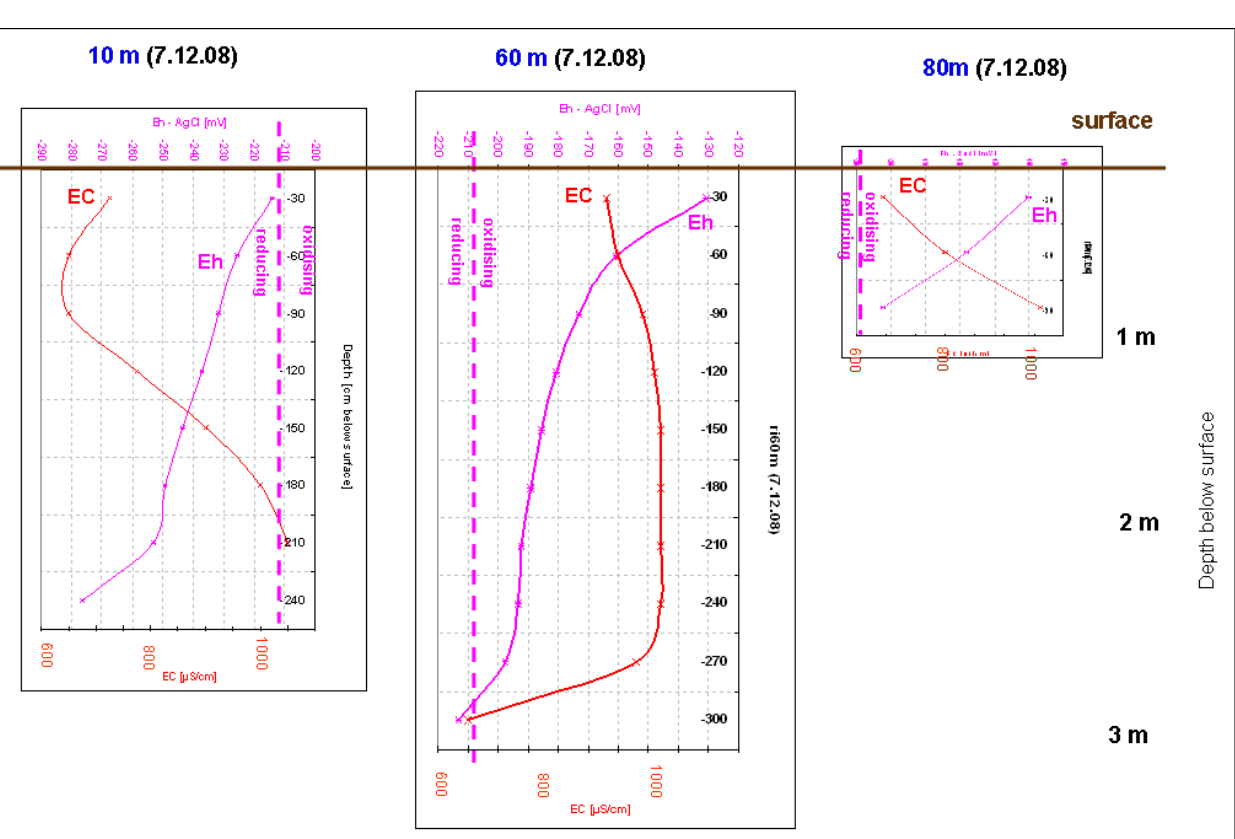
Figure 20. Vertical gradients of the EC and redox potential (Eh) in peat porewater as measured in boreholes of the transect at portion